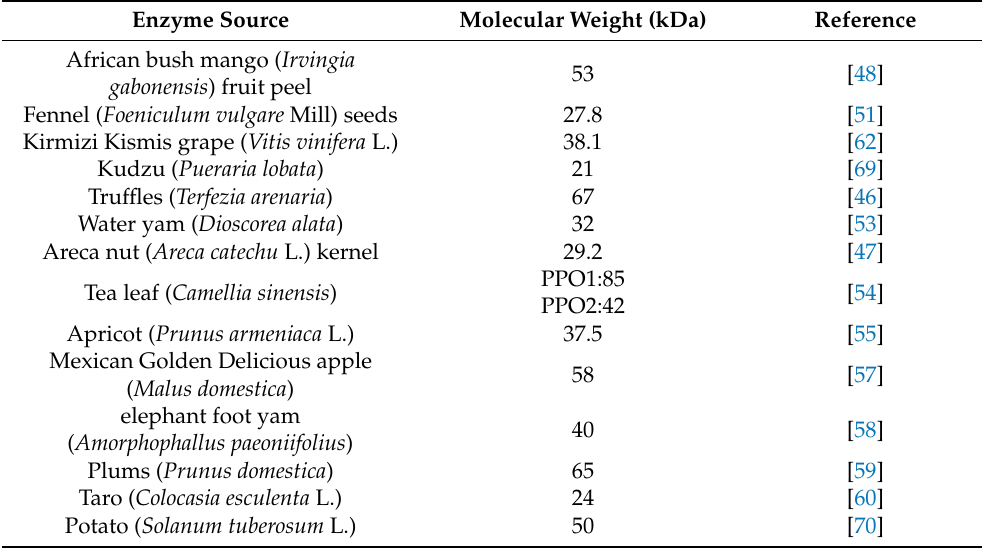
Table 4. Molecular weight of PPO in different plants.